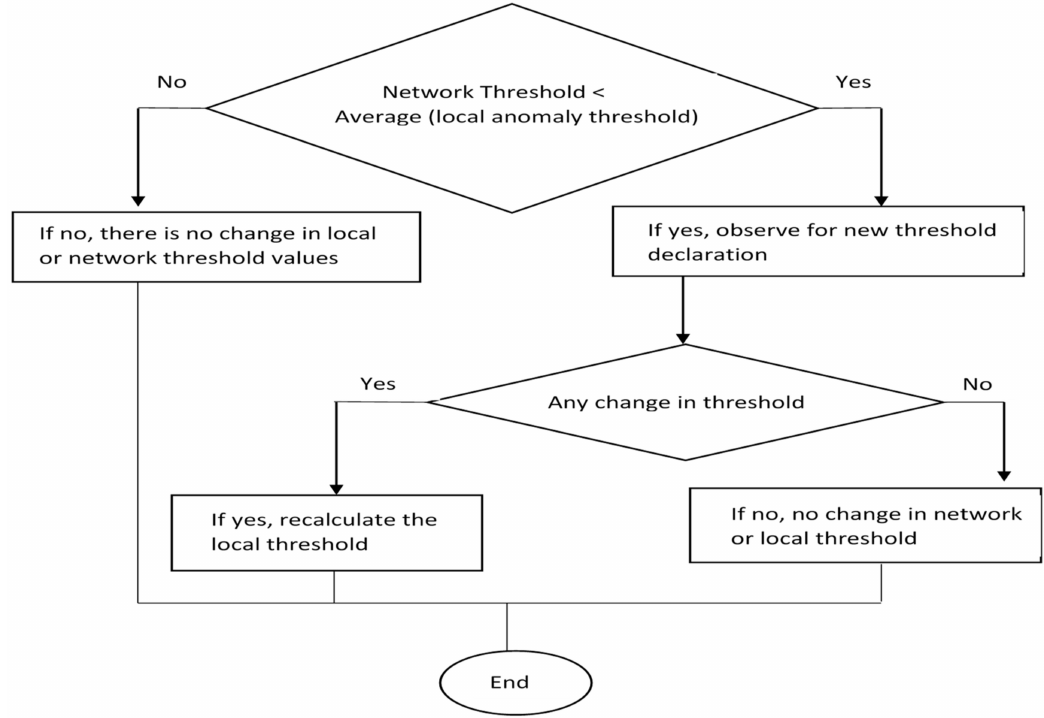
Figure 2. The proposed approach for outlier